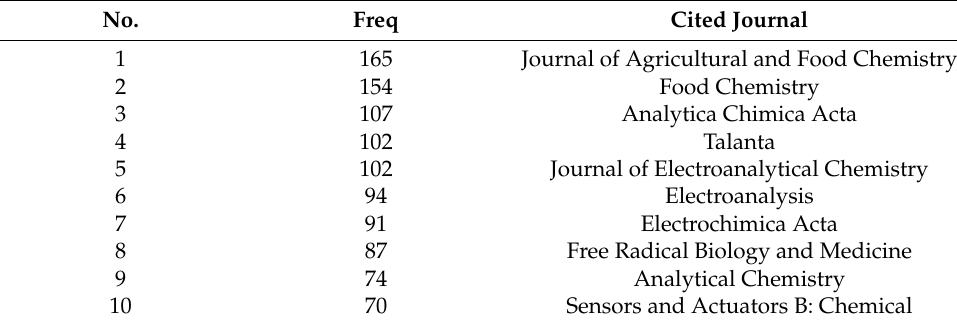
Table 1. Top 10 cited journals with the highest frequency.